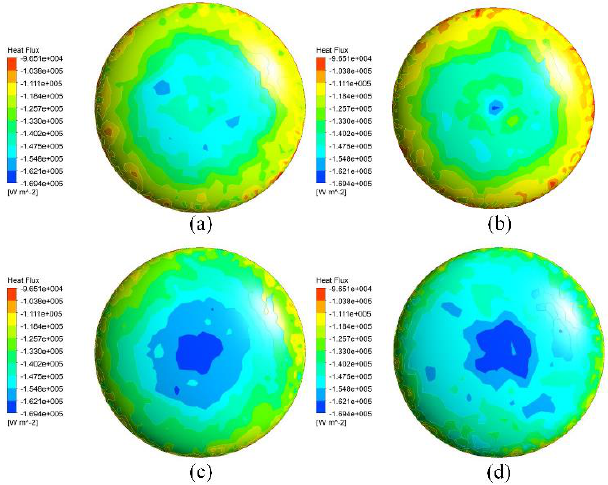
Figure 16. The heat flux through the bottom of stirred tanks with different blade heights. ( a ) h = 30